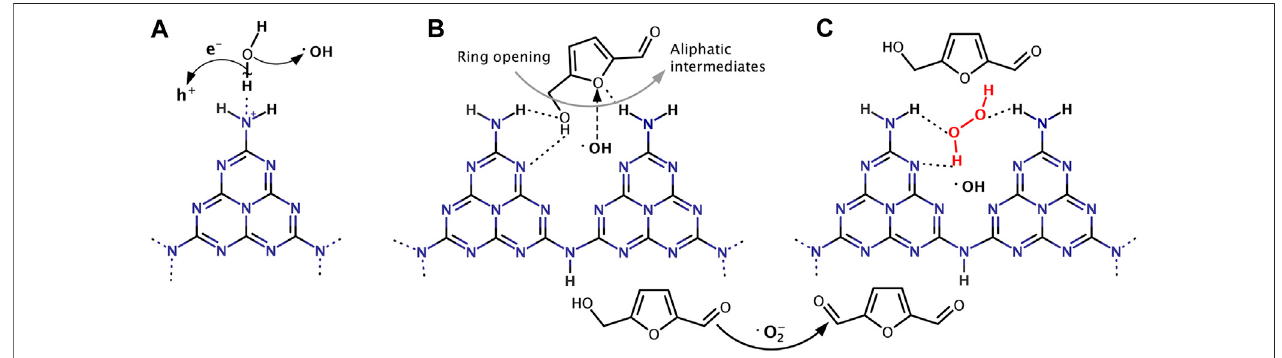
FIGURE 7 | (A) Hypothetical mechanism of hydroxyl radical formation on g-C 3 N 4 basic sites. (B) Proposed types of interaction and photooxidation of HMF on g-C 3 N 4 , and (C) on g-C 3 N 4 -H 2 O 2